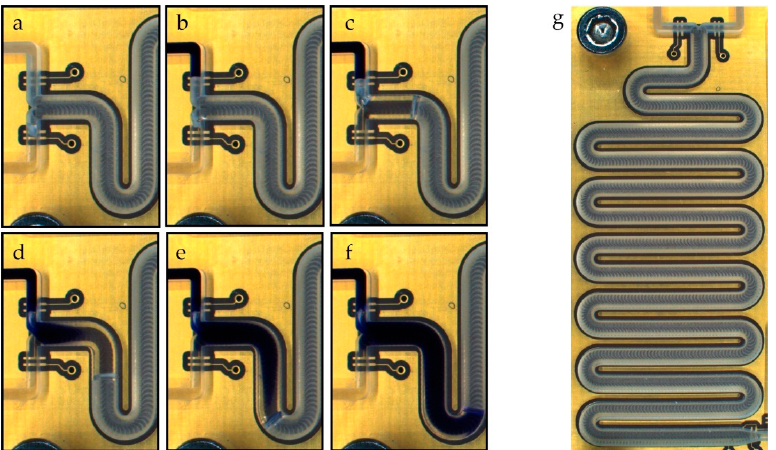
Figure 9. Alternate drive mixing of deionized water using Trypan blue as the dye. The image sequence shows the filling of the meander channels and two alternating dosing steps using a 10 µL packet size. ( a ) Water supply channel filled (left bottom channel). ( b ) Colored supply channel filled (left top channel). ( c ) First packet of pure water is dosed into the channel. ( d ) and ( e ): Colored water is dosed into the channel. ( f ) Result after dosing one packet of water and one packet of dyed water. ( g ) Image of the complete meander. The digital electrodes can be seen on each inlet and at the end of the meander. The golden meander electrode is slightly visible below the milled channel.